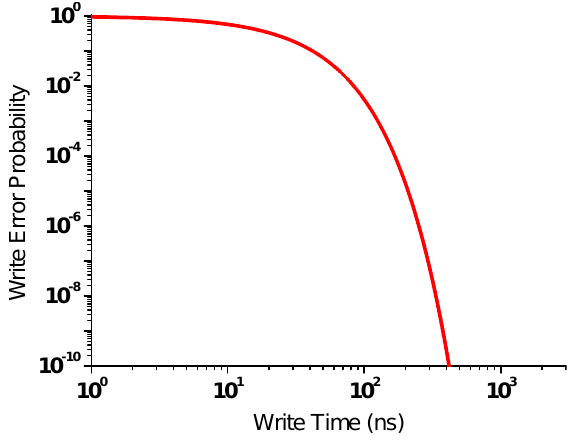
Figure 12. Write error probability of a MTJ at various write